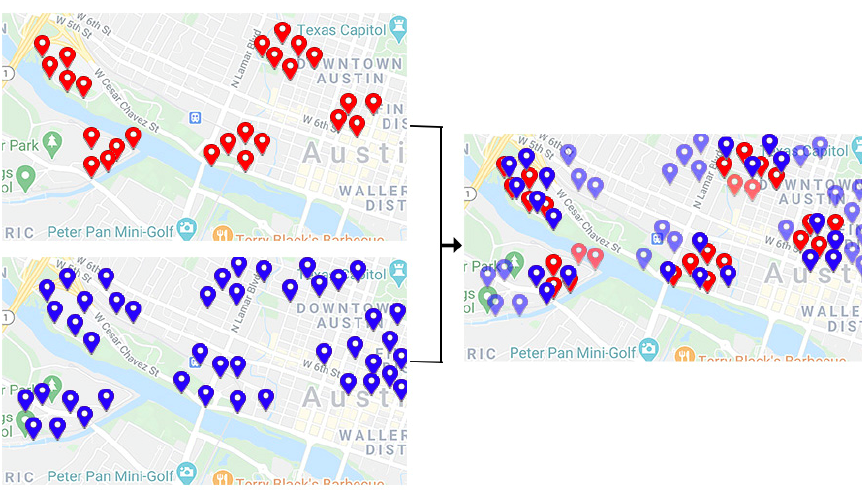
Figure 2. Schematic of calculation of the overlapping clusters.